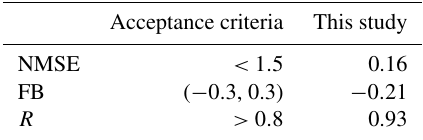
Table 4. Static values of the 3D pollutant dispersion